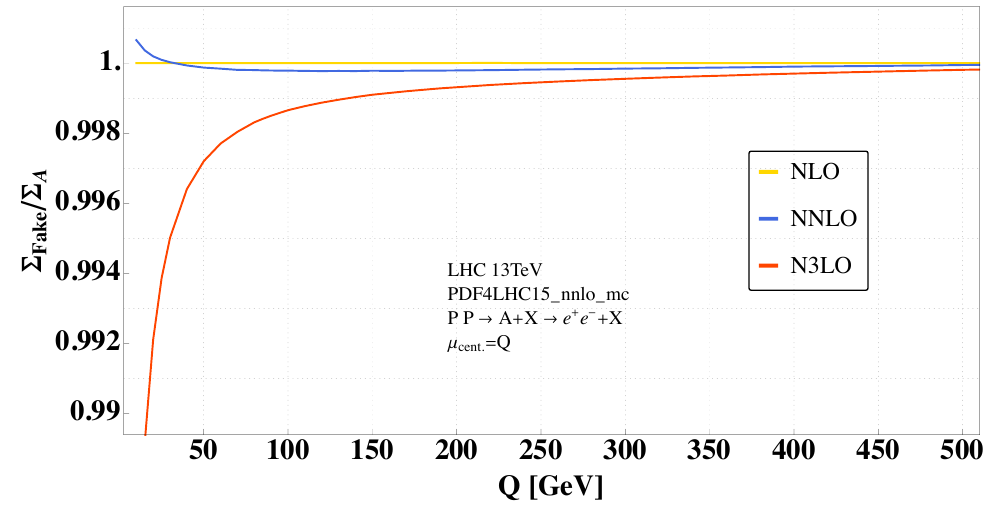
Figure 17. Relative difference of approximating the axial-vector production cross section by a pure vector contribution as a function of Q at different order in perturbations theory.